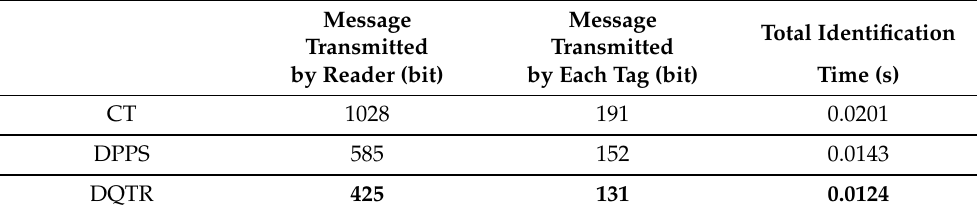
Table 5. Compared with CT and